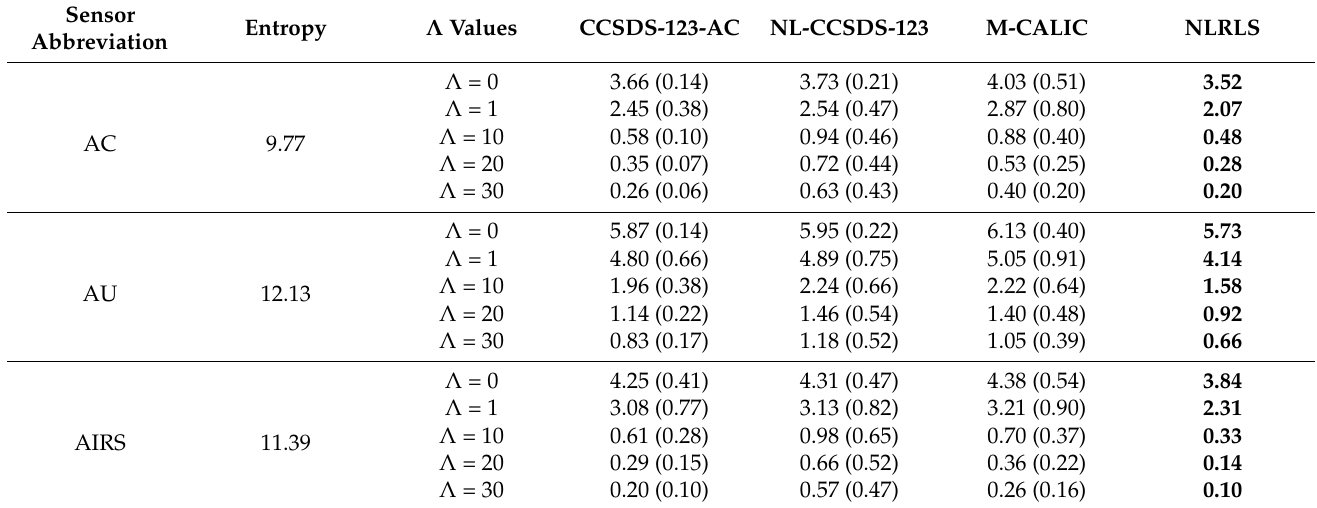
Table 2. Comparison of different near-lossless schemes for several different peak absolute